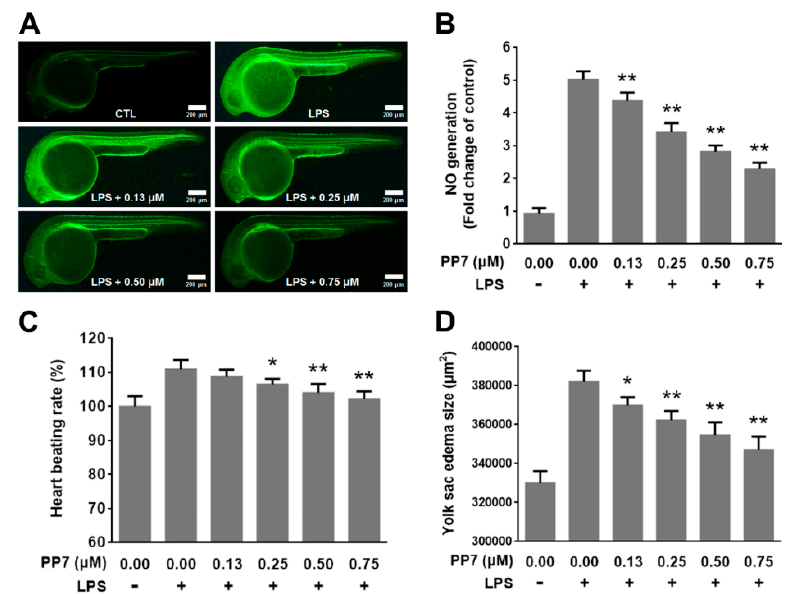
Figure 5. Anti-inflammatory and protective effects of PP7 in LPS-induced inflammation in zebrafish embryo. Zebrafish embryos at 8 h post-fertilization (hpf) were pretreated with PP7 and exposed to LPS. ( A ) The NO generation in zebrafish larvae was measured by image analysis and fluorescence microscope after staining with 4-amino-5-methylamino-2’,7’-difluorofluorescein diacetate (DAF-FM-DA). Scale bars represent 200 µ m. ( B ) Quantitative analysis of fluorescence intensity of ( A ) using an image J program. Effects of PP7 on heart beat rate ( C ) and yolk sac edema size ( D ) of LPS treated zebrafish embryos. Data are represented as means ± SD from three independent experiments. n = 10/group, * p < 0.05, ** p < 0.01 as compared with LPS-treated alone.